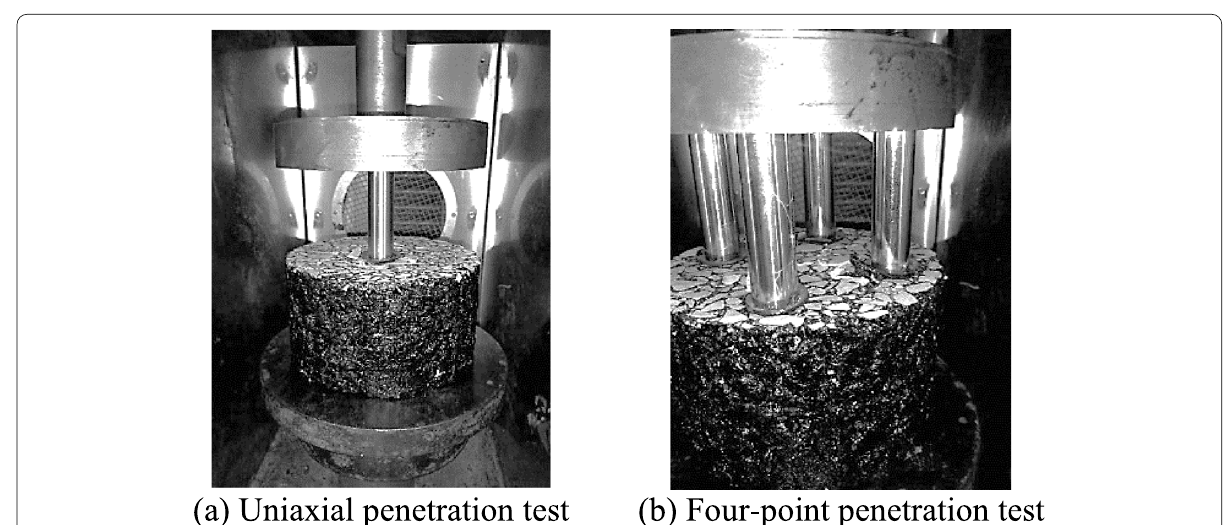
Fig. 4 Equipment installation of the penetration test. ( a ) Uniaxial penetration test. ( b ) Four-point penetration test